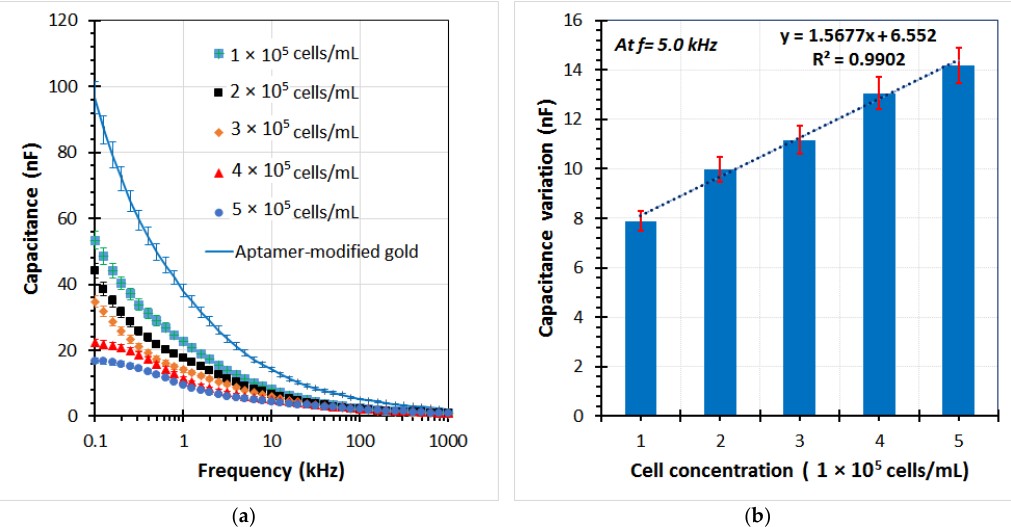
Figure 8. ( a ) Capacitance element of the impedance response for several A549 cell samples trapped on the aptamer-based sensing electrodes of the microchip by using the impedance analyzer at different cell concentrations, ( b ) The capacitance change of the chip with different cell concentrations respect to the aptamer-modified electrodes at frequency of 5 kHz.